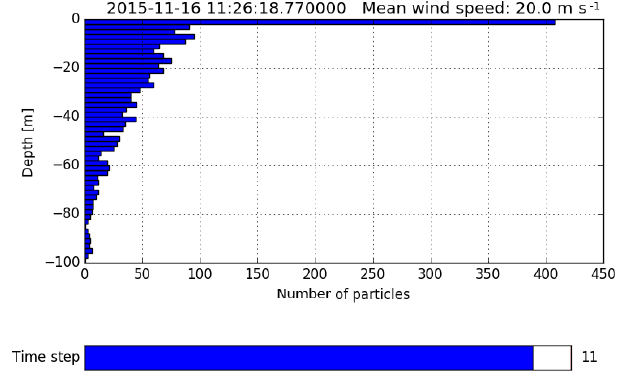
Figure 5. Vertical profile of the amount of (oil) elements. The bot- tom bar is an interactive slider, which the user can pull left/right to see the time variation of the vertical